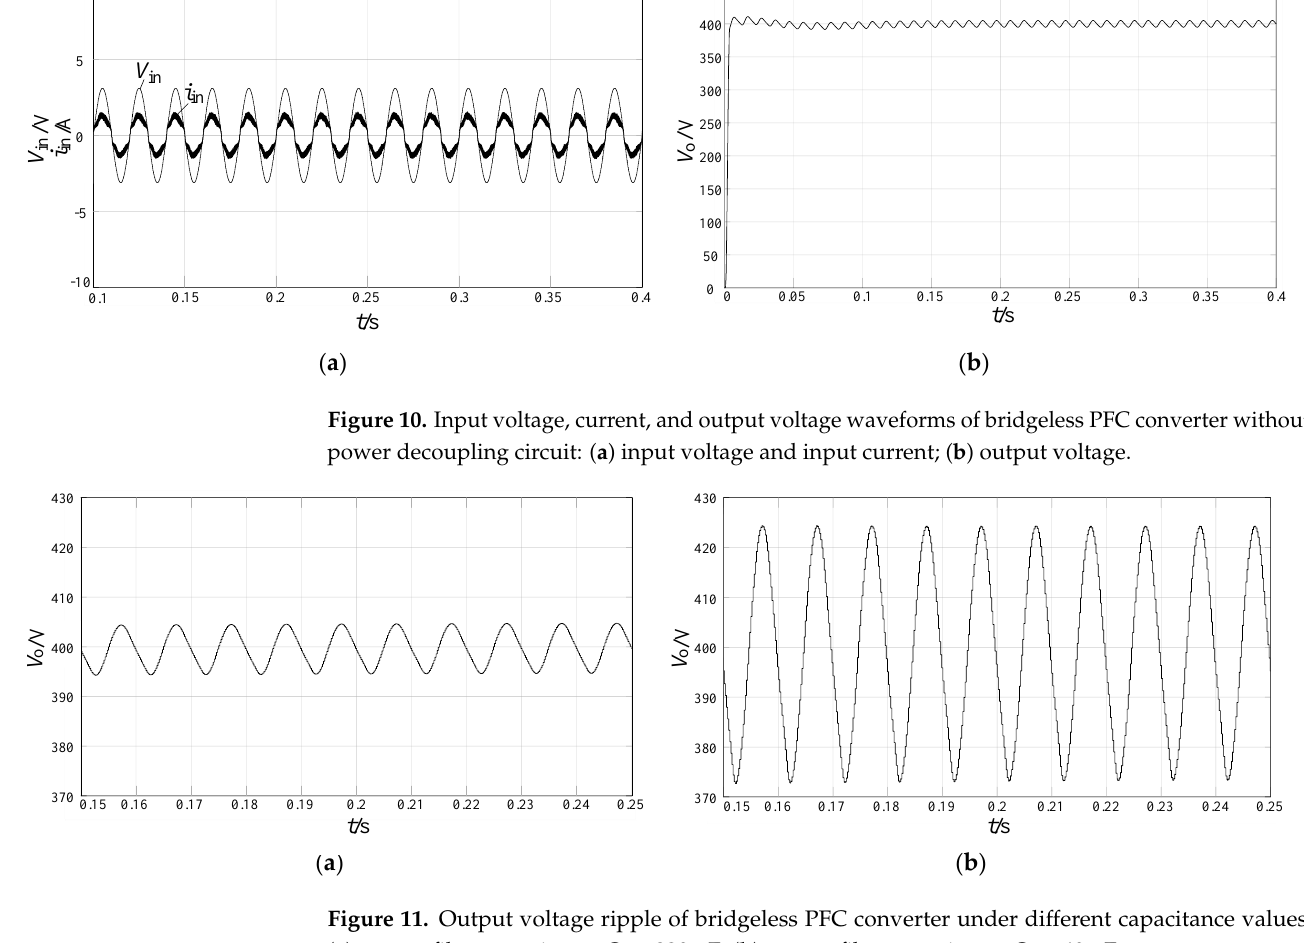
Figure 10. Input voltage, current, and output voltage waveforms of bridgeless PFC converter with- out power decoupling circuit: ( a ) input voltage and input current; ( b ) output voltage.